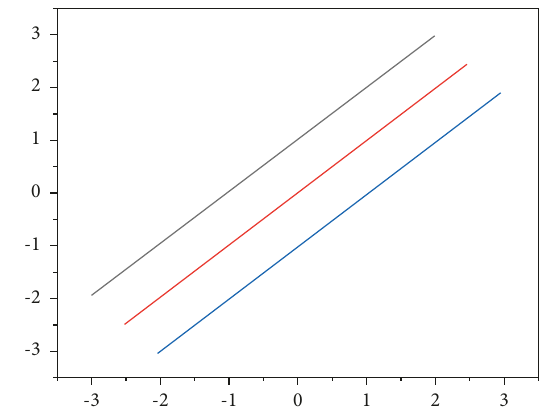
Figure 3: Characteristic value variation curve of support vector